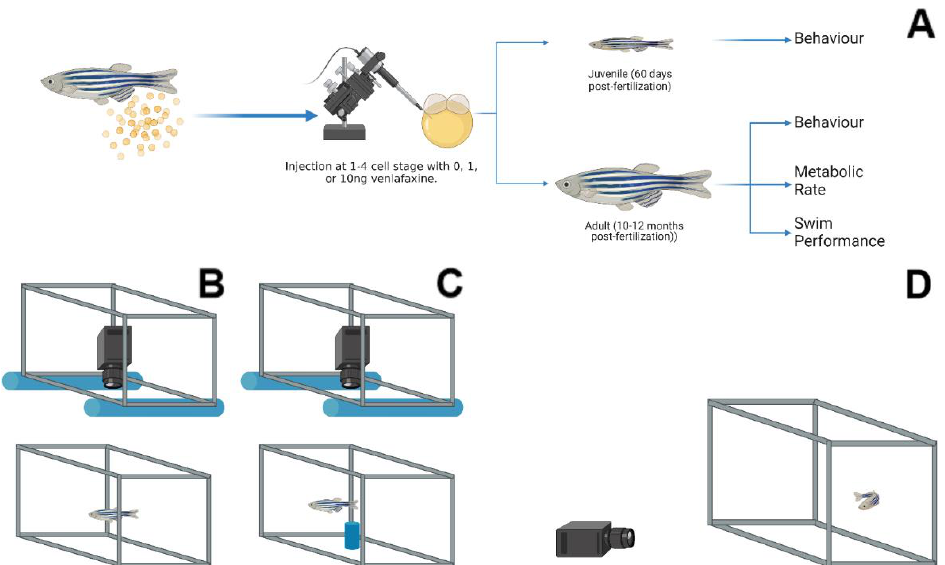
Figure 1. Experimental design and behavioural assessments. ( A ) Zebrafish eggs were collected immediately after fertilization and microinjected with either 0, 1 or 10 ng venlafaxine. Eggs were raised to either 60 dpf, and assessed for behaviour, or until 10–12 months post-fertilization and assessed for behaviour, metabolic rate, and swim performance. A top-down camera view was utilized for Novel tank ( B ) and Novel object ( C ) assessments. An air stone (blue) was the novel object (C) placed in the aquarium. ( D ) Lateral view behavioural assessment was carried out with the camera placed on the same surface of the tank of interest (D). The images were created with BioRender.com.